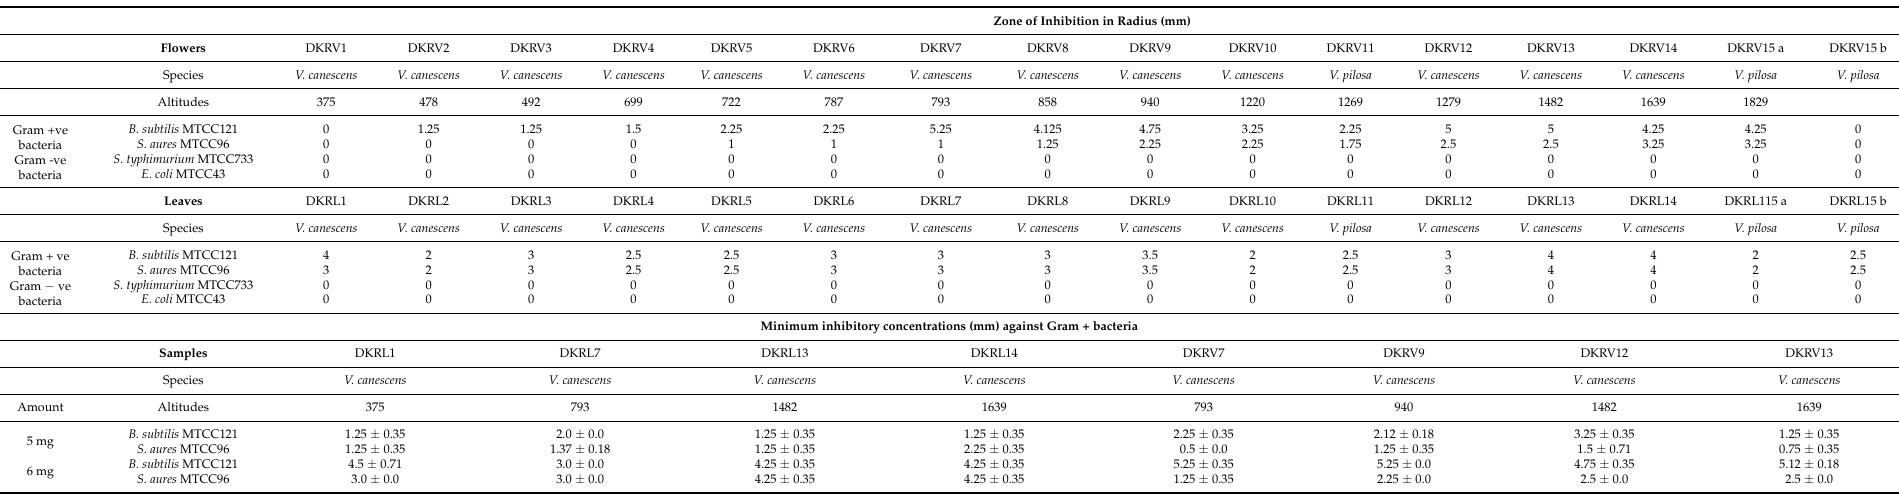
Table 3. Antimicrobial screening of Viola species (10 mg/mL) against bacterial strains and MICs of the most effective plant extracts against Gram-positive bacterium, i.e., S. aureus MTCC96 and B. subtilis MTCC121.